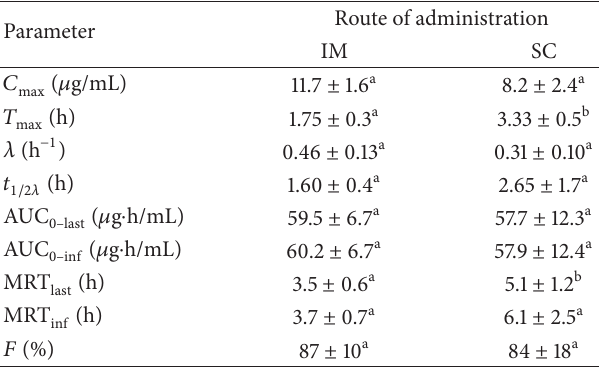
Table 2: Pharmacokinetic parameters (mean ± SD) calculated for sustained release cephalexin following an intramuscular (IM) and subcutaneous (SC) 8 mg/kg injection to 6